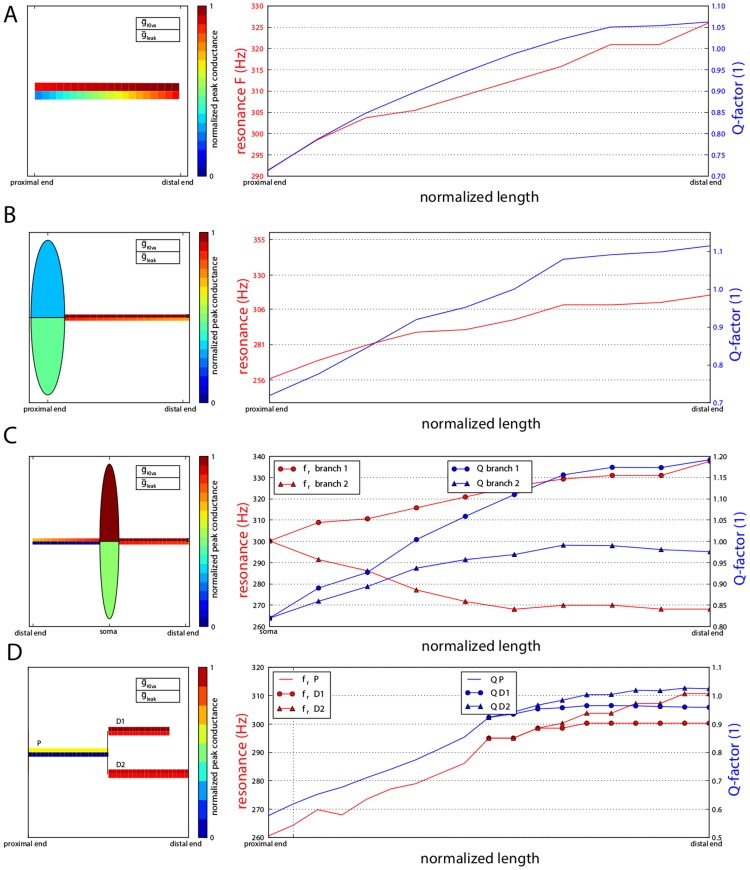
Optimized membrane parameters to achieve the largest range of resonant frequencies with high sharpness (Q-factor).A. Left panel: a sketch of the model cable with non-uniform density of  and  color-coded and normalized to the allowed range (see Methods). Right panel: Optimized range of resonance frequencies (red) and sharpness (blue) along the cable. A gradient of  against a constant high density of  produces the largest frequency range. B. Left panel: The Ball-and-stick model and its optimized conductance density profile. The optimized cable diameter and soma radius are also drawn to scale in the sketch. A similar type of gradient can be observed as in Panel A. Right panel,:Spatial profile of the resonance frequency (red) and sharpness of tuning (blue). C.
Left panel, bipolar model and non-uniform density of  and . Right panel: Spatial profile of resonance frequency (in red) and sharpness of tuning (in blue) with markers indicating the distinct left and right branches. D. Left panel: The “Y-branch” model and its optimized non-uniform density of  and . Right panel: Spatial profile of resonance frequency and sharpness of tuning with markers indicating parent (P) and daughter one (D1) and two (D2) in D.